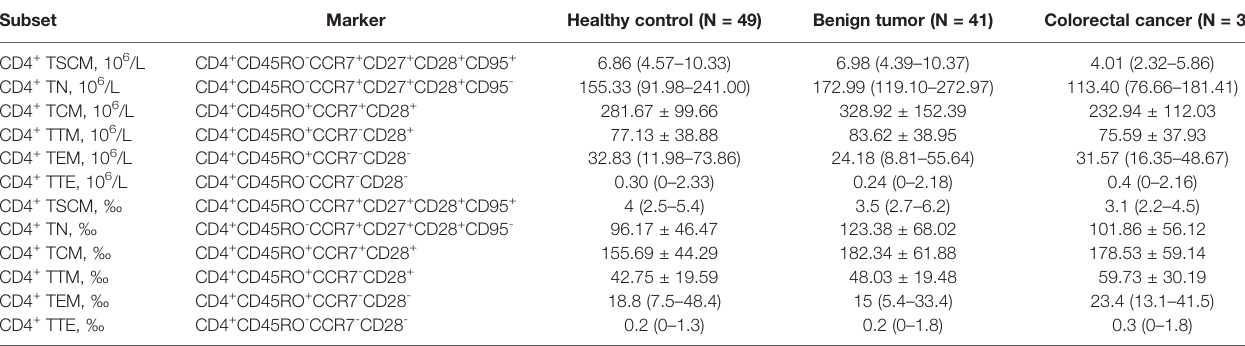
TABLE 2 | Expression levels of CD4 + T lymphocyte subsets in peripheral blood in the colorectal cancer, benign tumor, and healthy control groups. Subset Marker